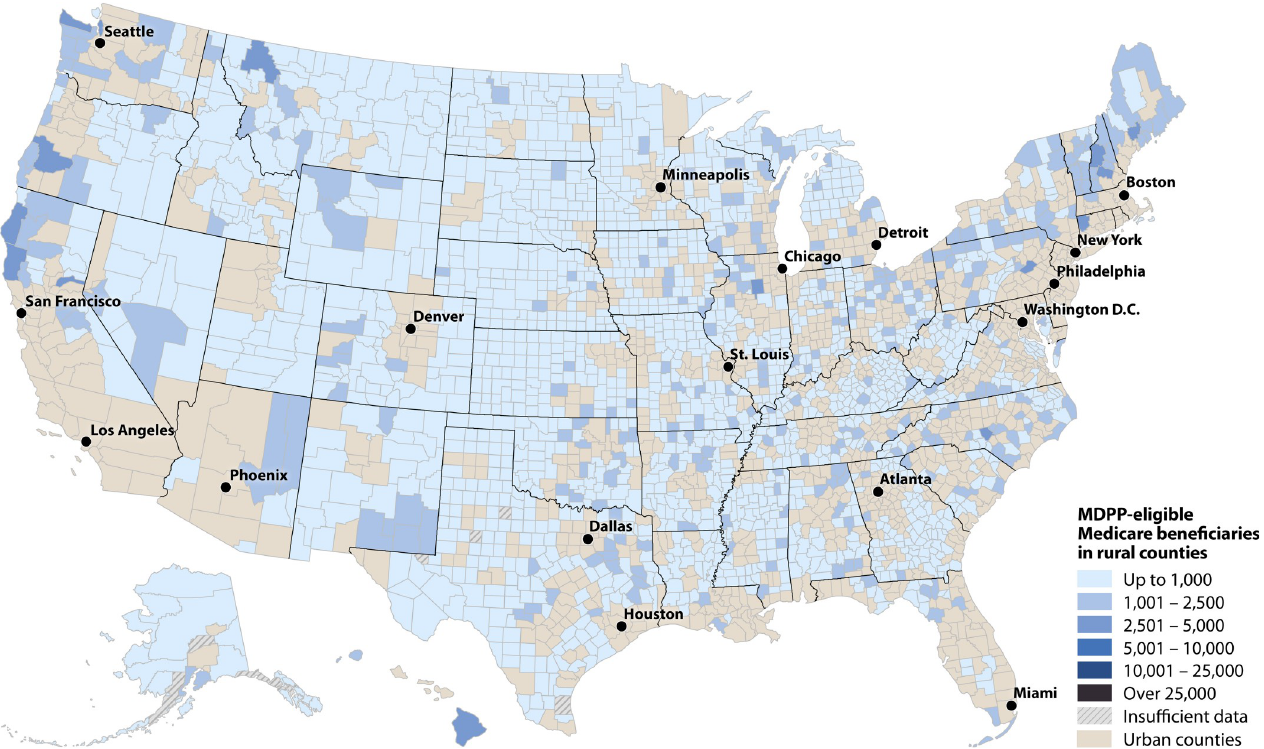
Fig 4. Estimated number of MDPP-eligible beneficiaries in rural counties, 2015.